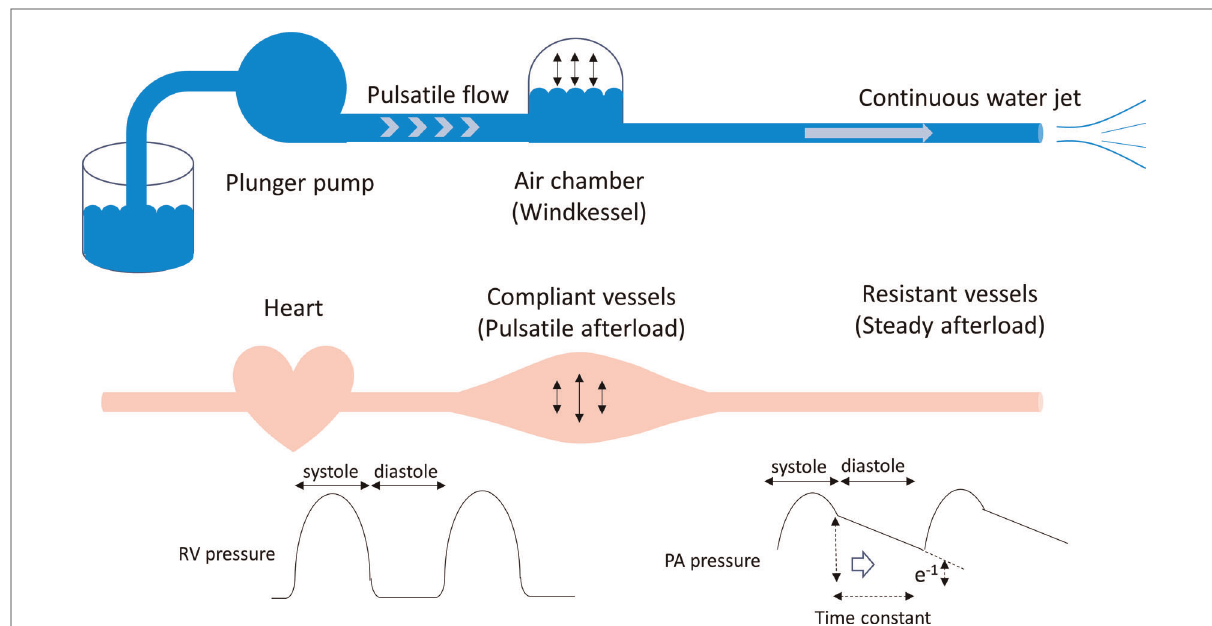
FIGURE 1 Windkessel model. The rhythmic water output of the plunger strokes is transformed into a continuous water jet downstream through an air tank. In terms of the pulmonary circulation, the plunger pump, an air tank, and a duct represent the heart, compliant vessels, and resistant vessels, respectively. The pulmonary arterial input impedance consists of compliant and resistant vessels, which determine the right ventricular afterload. The product of Rp and Cp is time-constant, which is an exponential pressure decay in diastole, referring time until pulmonary arterial pressure decreases to e − 1 (37%) of pulmonary arterial end-systolic pressure. Rp, pulmonary vascular resistance; Cp, pulmonary vascular